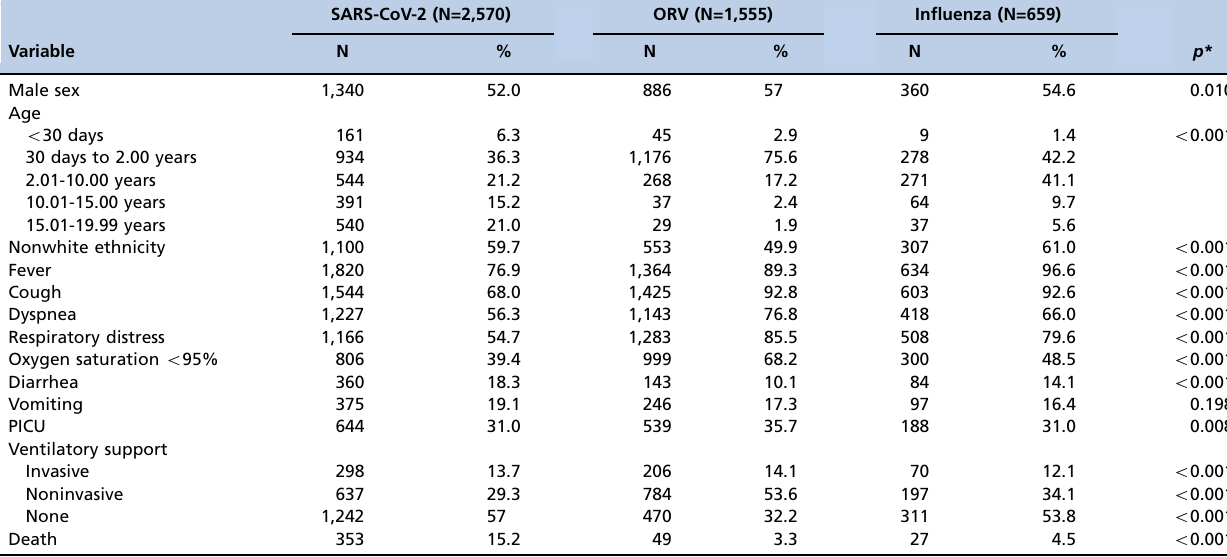
Table 1 - Demographic and clinical details of pediatric patients with severe acute respiratory infection according to viral